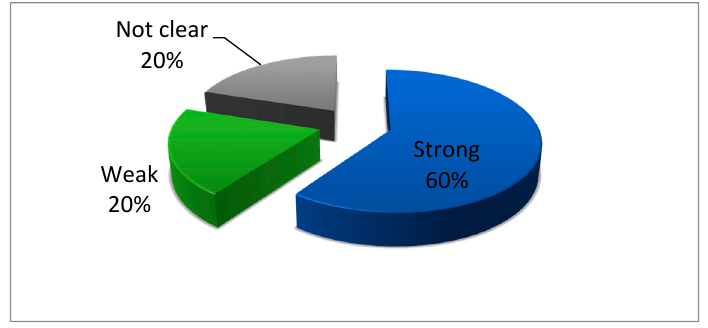
Figure 8. Level of trust between government agencies (according to the experts interviewed).